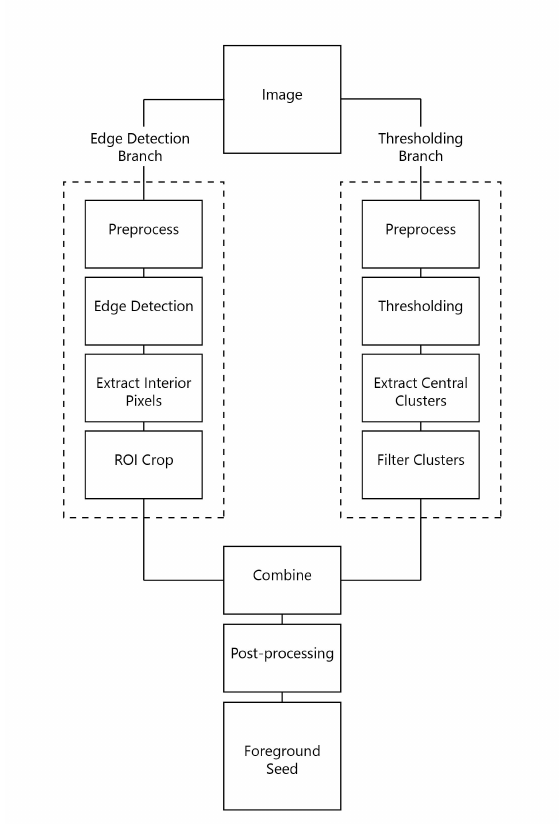
Figure 2. Pipeline proposed to generate high-precision foreground seeds. Two methods (edge detection and thresholding) are used to generate seed proposals independently. These proposals are further merged and